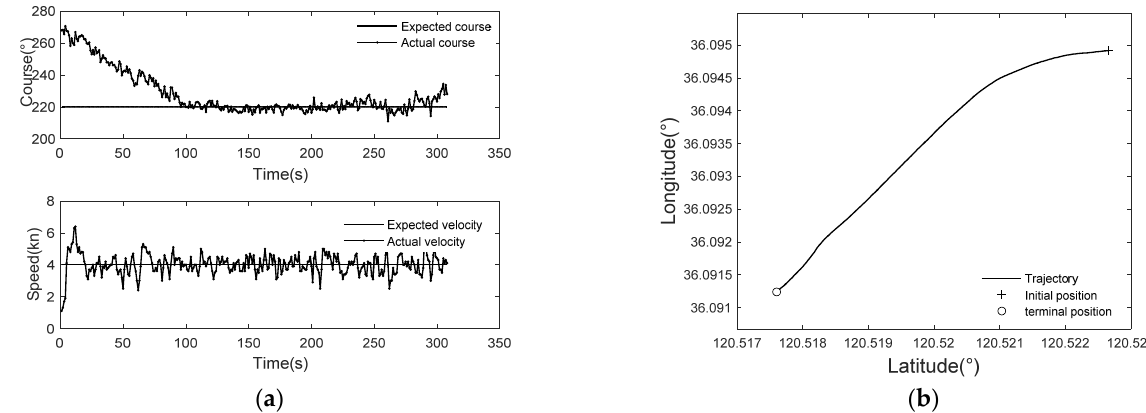
Figure 12. The course and speed control of the USV with expected course (220°) and speed (4 kn). ( a ) The coupled control for course and speed; ( b ) the corresponding trajectory of the USV.